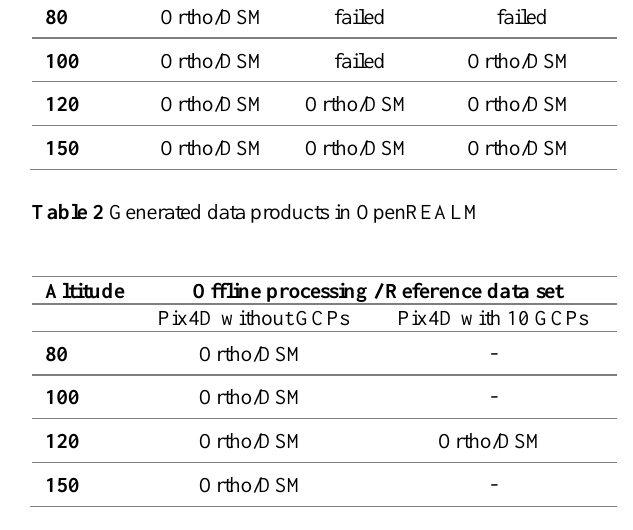
Table 3 Generated data products in